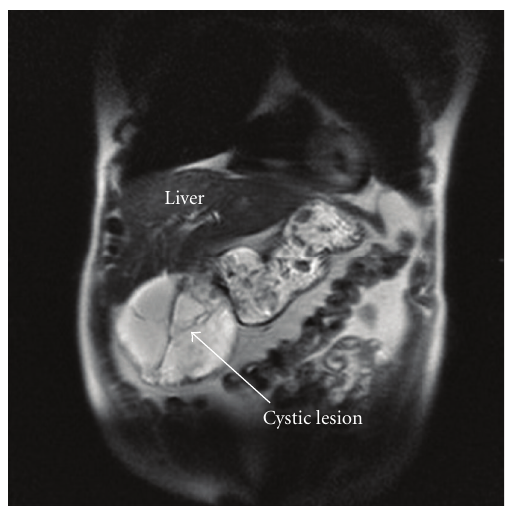
Figure 3: On MRI imaging markedly high intensity, compatible with cystic nature (arrow), was revealed in the tumor.